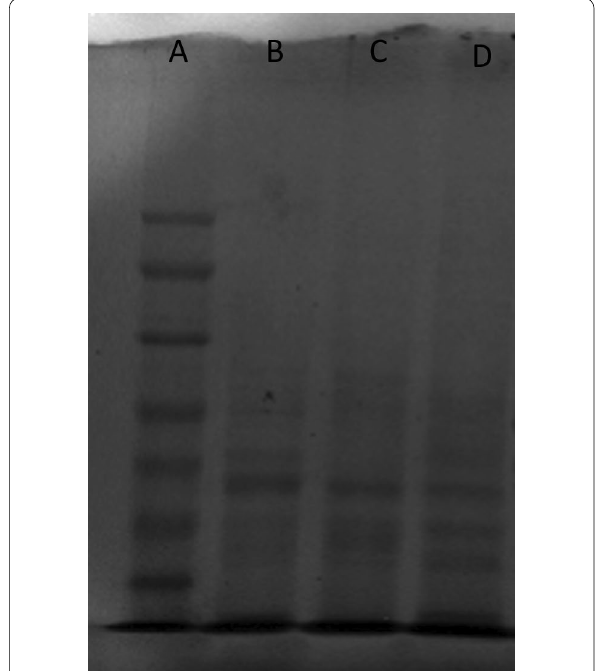
Fig.7 SDS protein bands detected in the whole-body homogenates of Locusta migratoria migratorioides 5th instar nymph treated with LC 50 of bacterial suspension and its Cell-free filtrate. ( A ) Marker, ( B ) Control, ( C ) Bacterial suspension, ( D ) (filtrate)